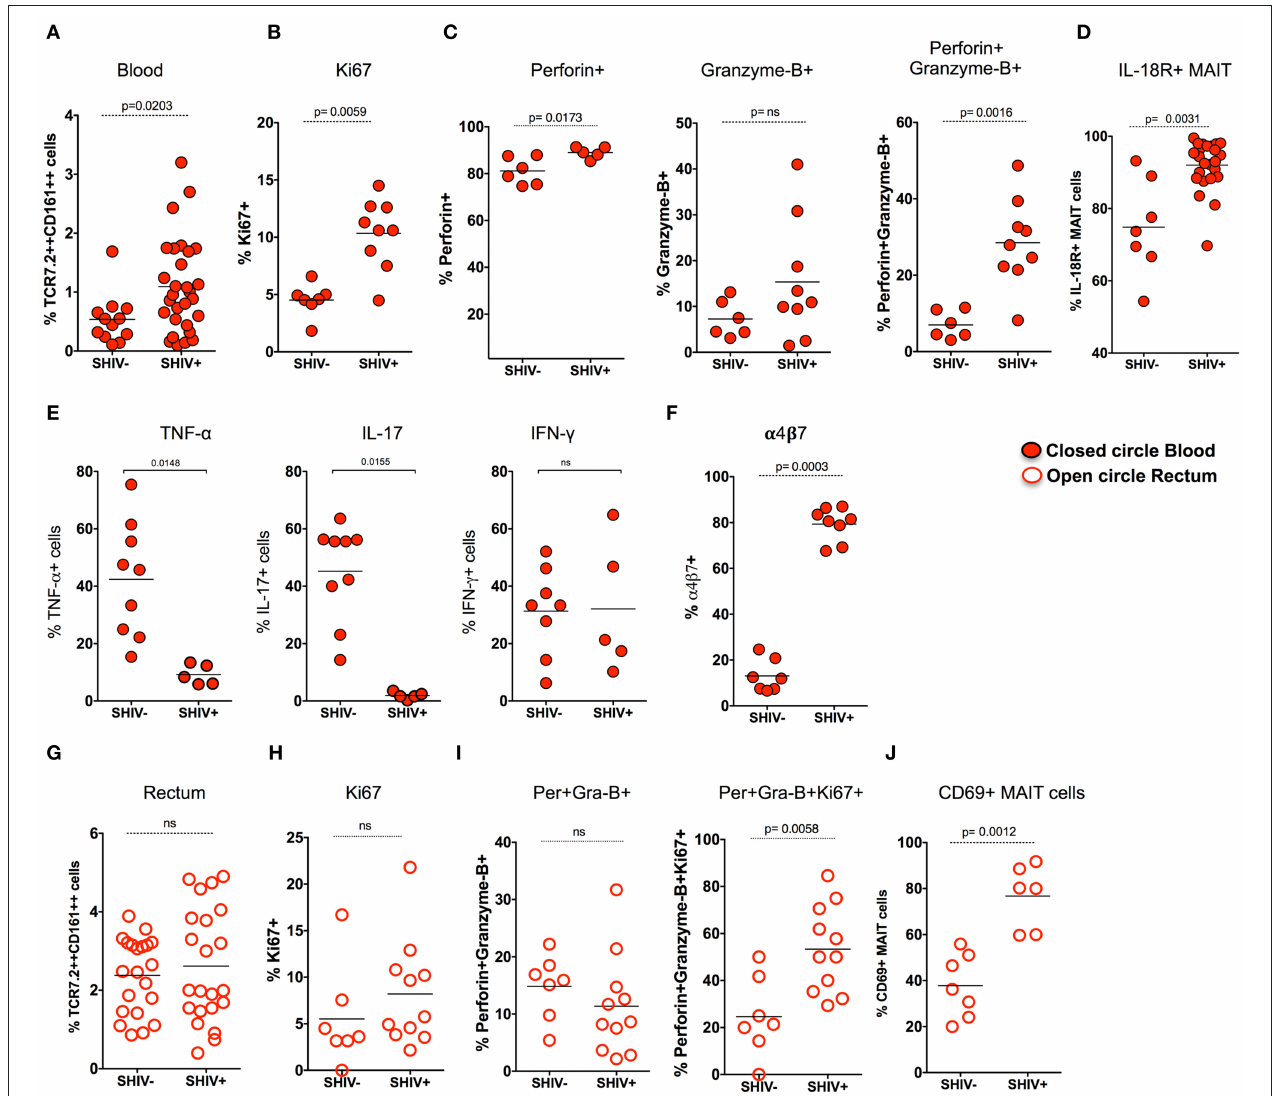
FIGURE 3 | MAIT cells in SHIV-infected macaques are highly proliferative and enriched with cytotoxic granules in blood and rectum. (A) Frequency of blood MAIT cells are significantly enriched during chronic ( > 14 weeks post-SHIV infection ( n = 29) and SHIV-naïve animals ( n = 14). (B) Frequency of Ki-67 + MAIT cells in blood before and after SHIV infection: SHIV-infected ( n = 9) and SHIV-naïve animals ( n = 7). (C) Frequency of perforin + , granzyme-B + , and perforin + granzyme-B + MAIT cells in blood are shown before and after SHIV infection: SHIV infected animals ( n = 9) and SHIV-naïve animals ( n = 8). (D) Frequency of IL-18R expressing MAIT cells in blood before and after SHIV infection: SHIV-infected ( n = 21) and SHIV-naïve animals ( n = 7). (E) Plots showing the cytokine-producing ability of MAIT cells post-SHIV infection. MAIT cells predominantly maintain IFN- γ production but lose the capacity to make TNF- α and IL-17 in SHIV-infected animals ( n = 5) and SHIV-naïve animals ( n = 9). (F) Data for the frequency of α 4 β 7 + MAIT cells before and after SHIV infection: SHIV-infected animals ( n = 8) and SHIV-naïve animals ( n = 7). (G) Frequency of rectal MAIT cells is maintained post-chronic SHIV infection ( n = 22) compared to SHIV-naïve animals ( n = 21). (H) Frequency of Ki-67 + MAIT cells in rectum before and after SHIV infection: SHIV-infected animals ( n = 11) and ( n = 7) SHIV-naïve animals. (I) Frequency of perforin + , granzyme-B + , and Ki67 + perforin + granzyme-B + MAIT cells in rectum are shown before and after SHIV infection: SHIV-infected animals ( n = 11) and SHIV-naïve animals ( n = 7). (J) Frequency of CD69 + MAIT cells in rectum before and after SHIV infection: SHIV-infected animals ( n = 6) and SHIV-naïve animals ( n =